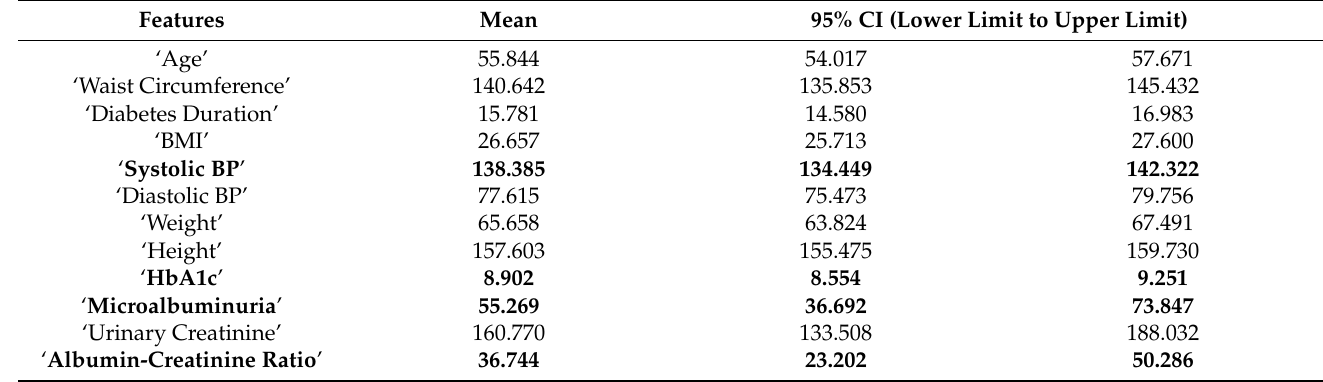
Table 7. 95% confidence intervals for diabetic peripheral neuropathy patients (categorical features, such as gender, smoking history, and smokeless tobacco history, have been omited from the table). The subject count is 90 (44 pDPN, and 46 nDPN patients), and the features that are used in the model classifier are marked in bold